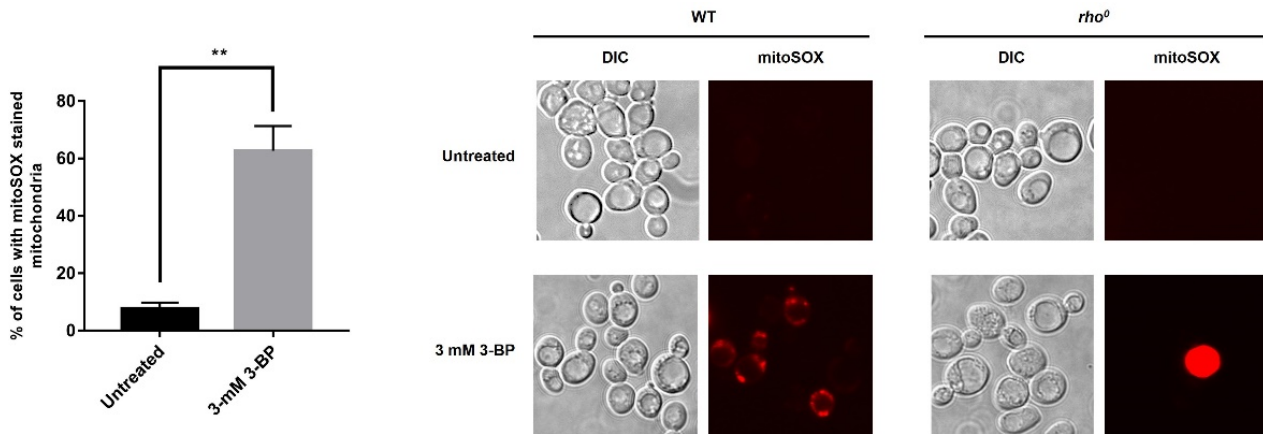
Figure 4. 3-BP induces generation of superoxide in mitochondria. Mitochondrial superoxide level was measured with a MitoSOX fluorescent probe. WT cells were treated with different 3-BP concentrations for 4 h and loaded with MitoSOX Red, signal was detected under a fluorescence microscope. The percentage of cells with a mitochondrial signal was calculated. Yeast cells that exhibit fluorescence from the whole-cell represent dead cells and were not taken into account. ** p ≤ 0.01.